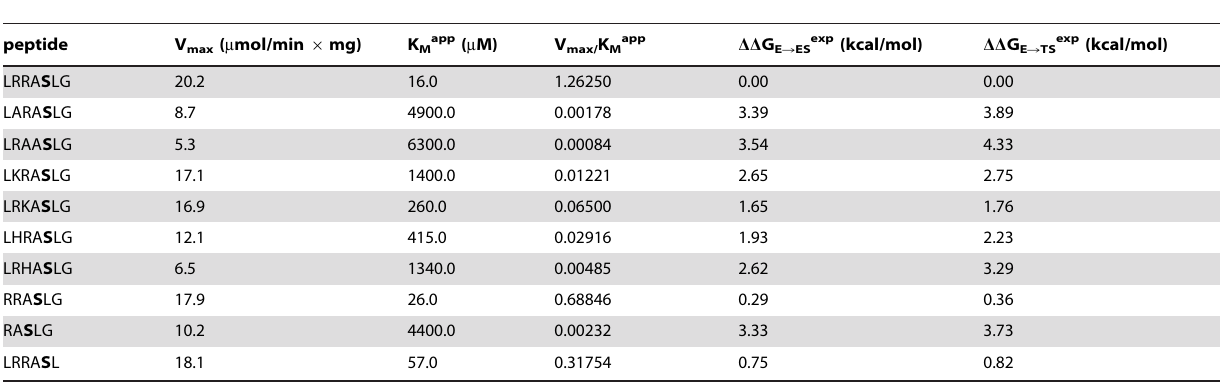
Table 1. Effect of replacing residues and chain length on kinetics of phosphorylation for the heptapeptide Kemptide (LRRASLG) a .